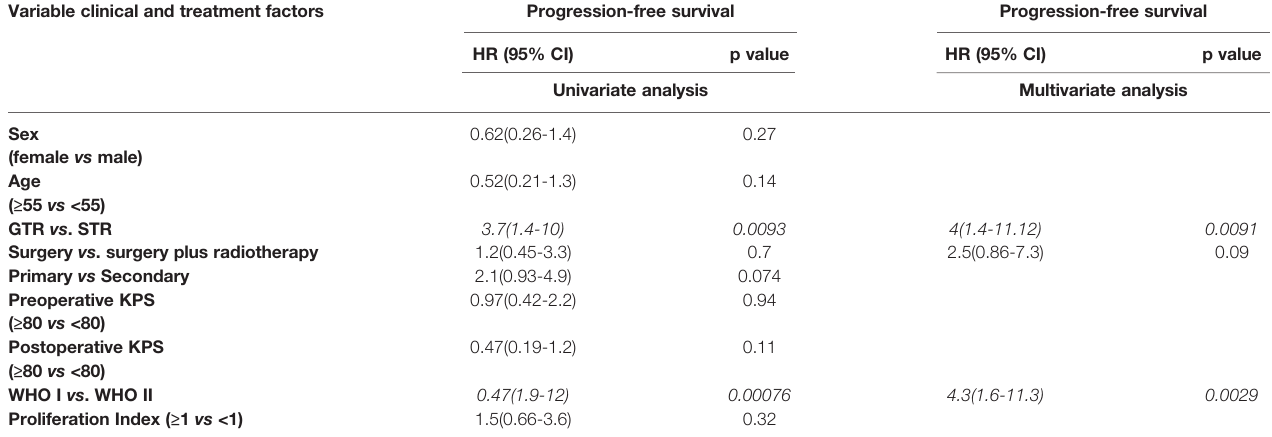
TABLE 2 | Cox regression analysis. Variable clinical and treatment factors